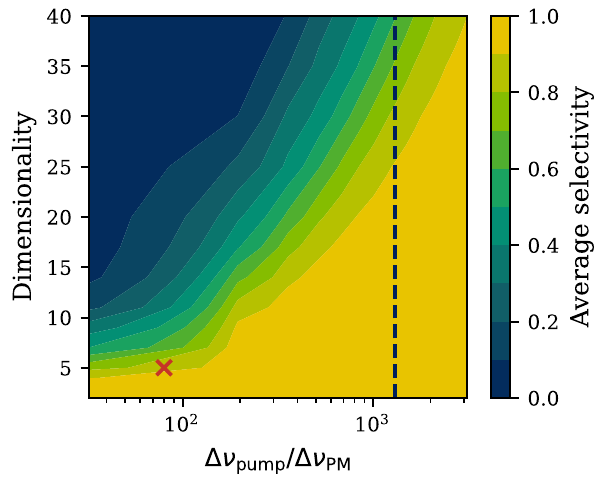
FIG. 9. Average purity and fidelity (with corresponding stan- dard deviations) of the POVMs of our implemented five- dimensional decoder for experimental data acquired with the CCD spectrograph (solid line) and the TOF spectrograph (dashed line) as a function of the spectral window around each central frequency.